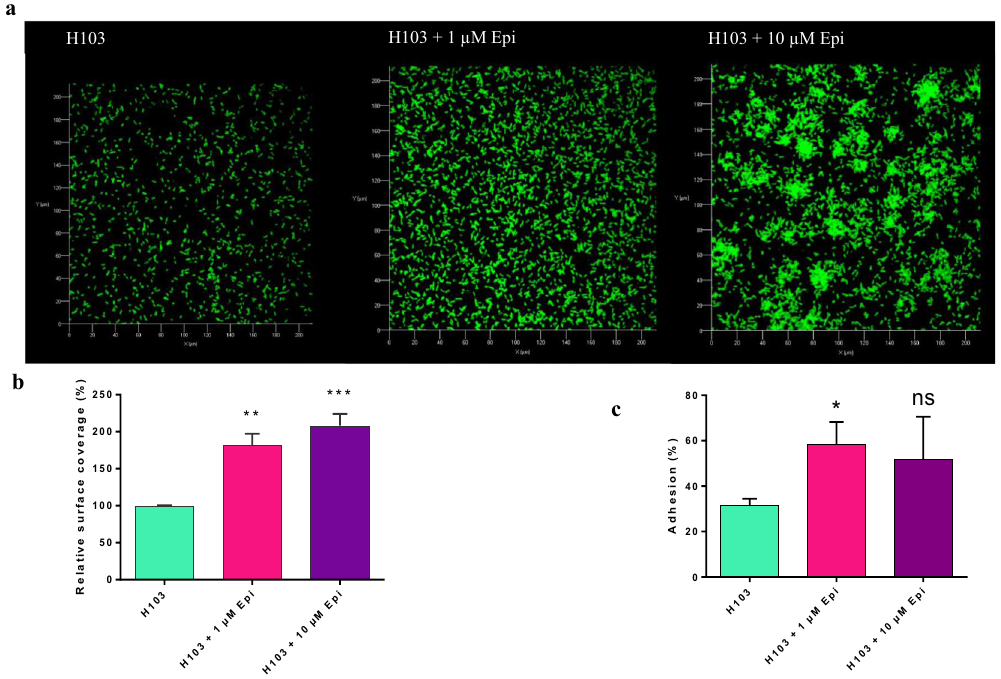
Figure 3. Effect of Epi on adhesion of P. aeruginosa H103. ( a ) Top view of P. aeruginosa H103-GFP adhesion observed by CLSM with two different concentrations of Epi (1 and 10 µ M), after 2 h. ( b ) Image analysis by COMSTAT. Data were normalized according to the untreated control set at 100%. ( c ) Adhesion assay on Caco-2/TC7 cells, * p = 0.0418. The error bars indicate the standard error of the mean (SEM). Two-tailed paired t -test was used (n = 5), ** p = 0.001222, *** p = 0.000413, ns: not